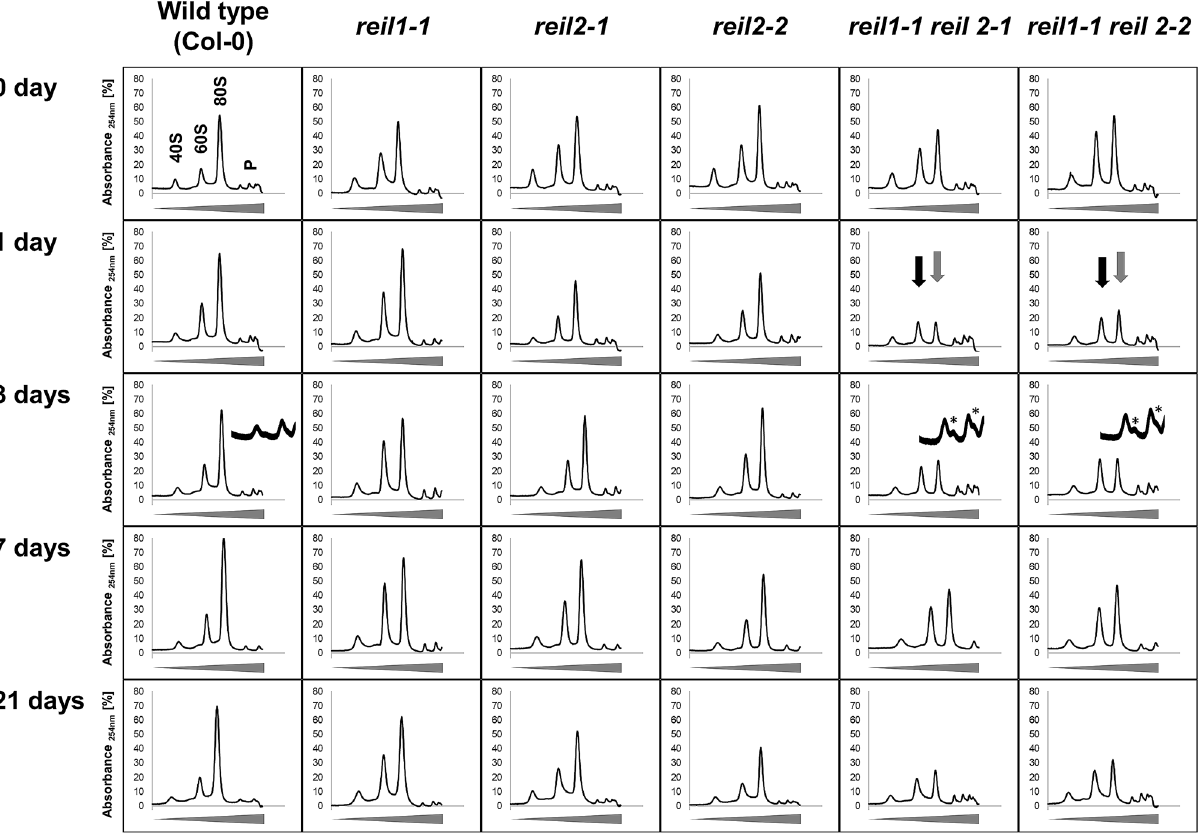
Figure 1. Sucrose density gradient analyses of ribosome complexes from equal amounts (fresh weight) of hydroponically grown total root material before (0 day) and at 1, 3, 7, or 21 days after shift from 20 °C (day)/ 18 °C (night) to 10 °C (day) and 8 °C (night). The Arabidopsis thaliana wild type (Col-0) was compared to the single-paralog mutants, reil1-1 , reil2-1 , reil2-2 , and to the double mutants, reil1-1 reil2-1 and reil1-1 reil2-2